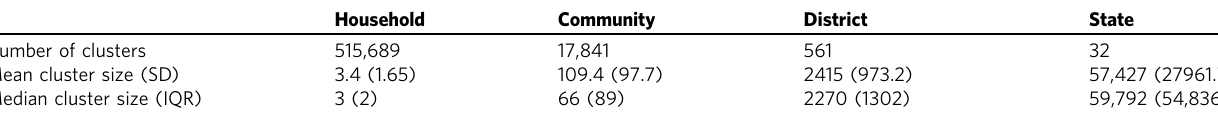
Table 2 Cluster characteristics a .